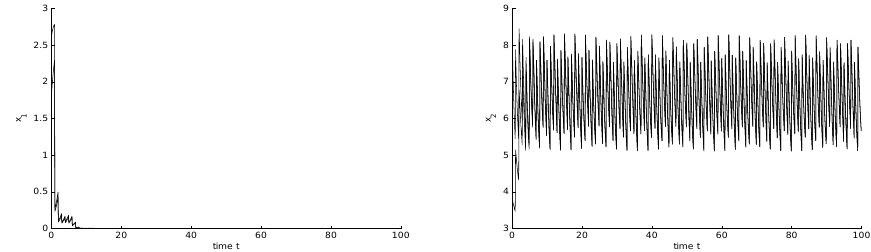
Figure 4: System (1.3) with ( ϕ 1 ( t ), ϕ 2 ( t )) = (2.6, 3.8) T and (1.8, 8.6) T for t ≤ 0 respectively.